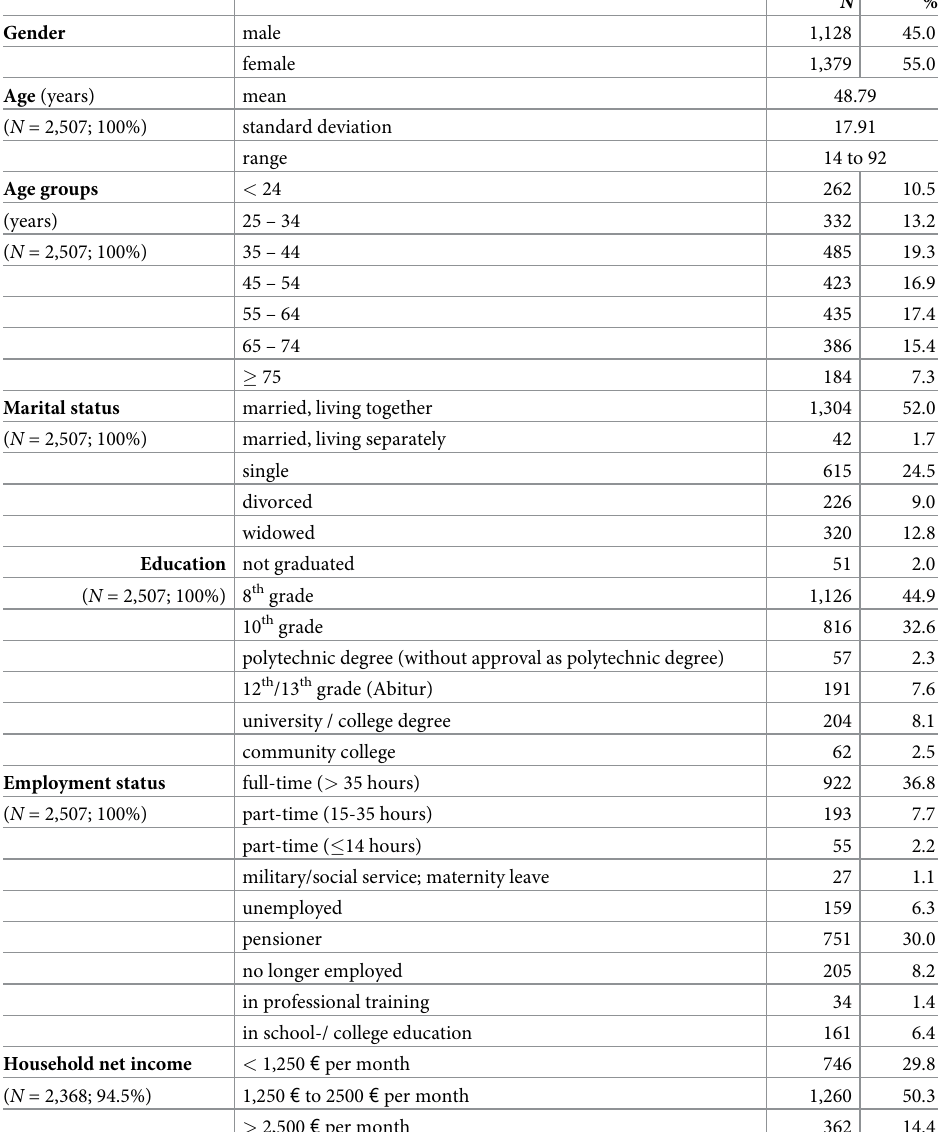
Table 2. Sample characteristics concerning sociodemographic